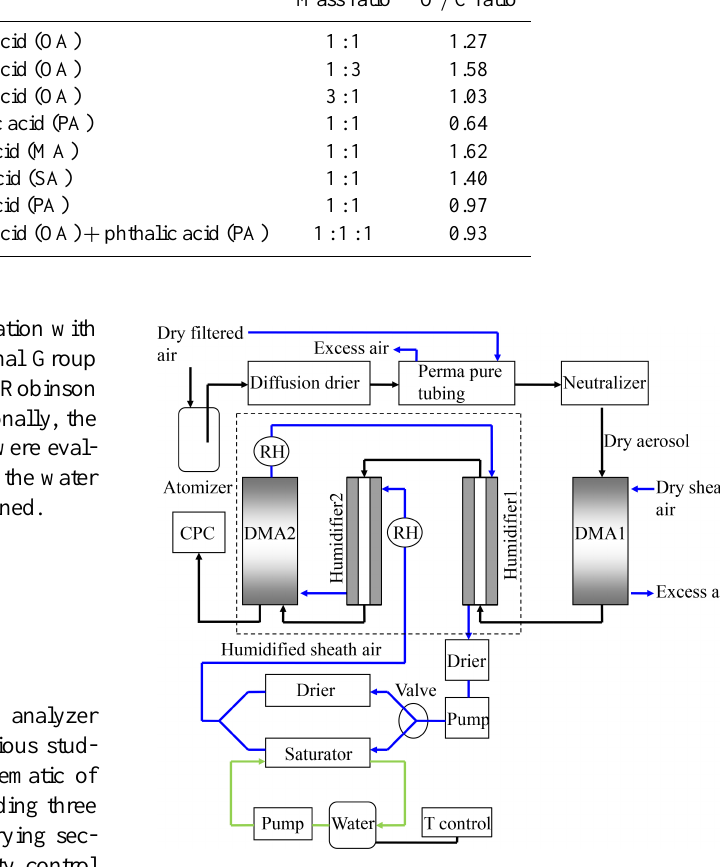
Table 2. Chemical composition and O / C ratio of mixtures used in experiments. Mixture